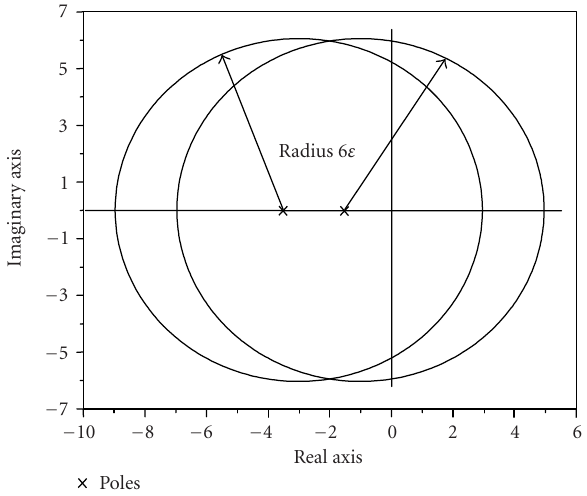
Figure 5.4. Possible situation of the first-order approximation unstable poles around the eigenvalues of A for ε =